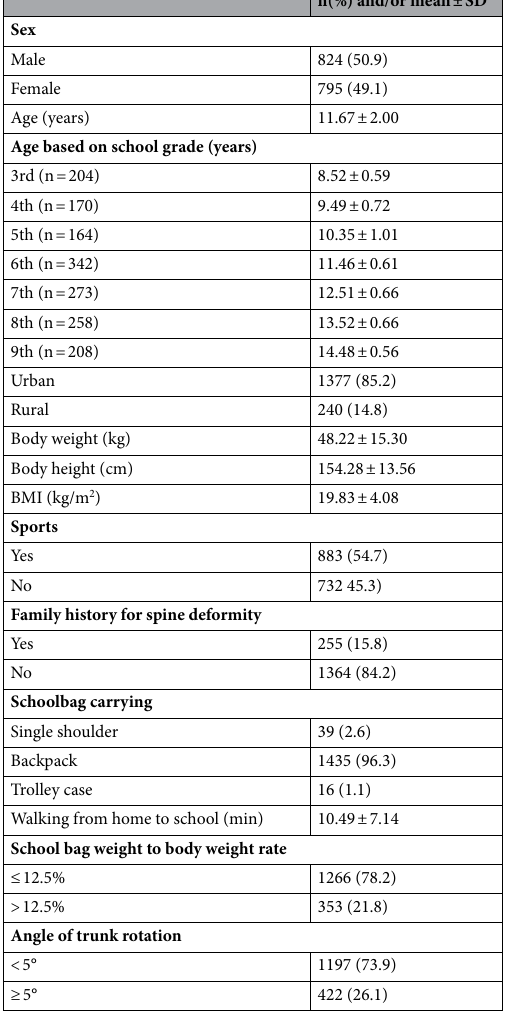
Table 1. Socio-demographic characteristics of study sample.